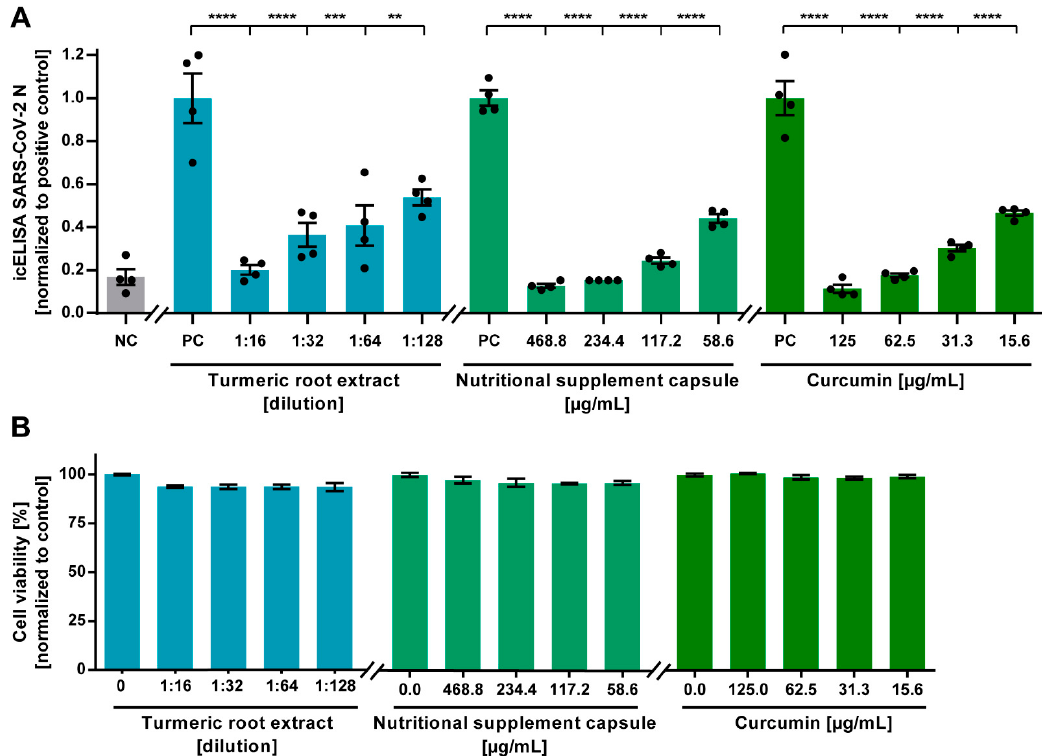
Figure 3. Neutralization of SARS-CoV-2 by aqueous turmeric root extract, curcumin-containing nutritional supplement capsules, and curcumin on a human cell line assessed by an in-cell ELISA (icELISA)-based neutralization test (icNT). ( A ) Decreasing concentrations of aqueous turmeric root extract (1:16–1:128 dilution), nutritional supplement capsule content (468.8–58.6 µ g/mL), or curcumin (125–15.6 µ g/mL) were pre-incubated with 5000 plaque-forming units (PFU) of